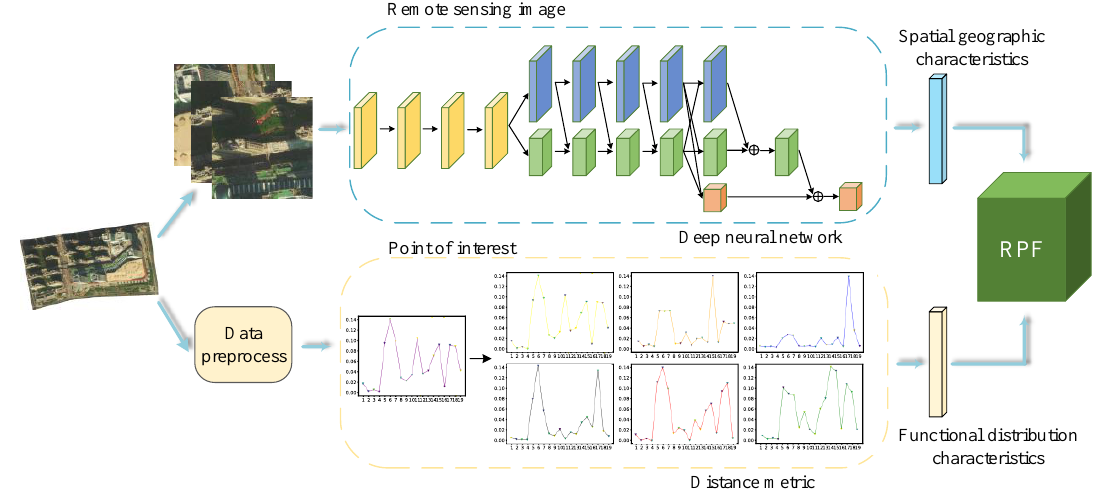
Figure 3. The framework for discovering urban functional